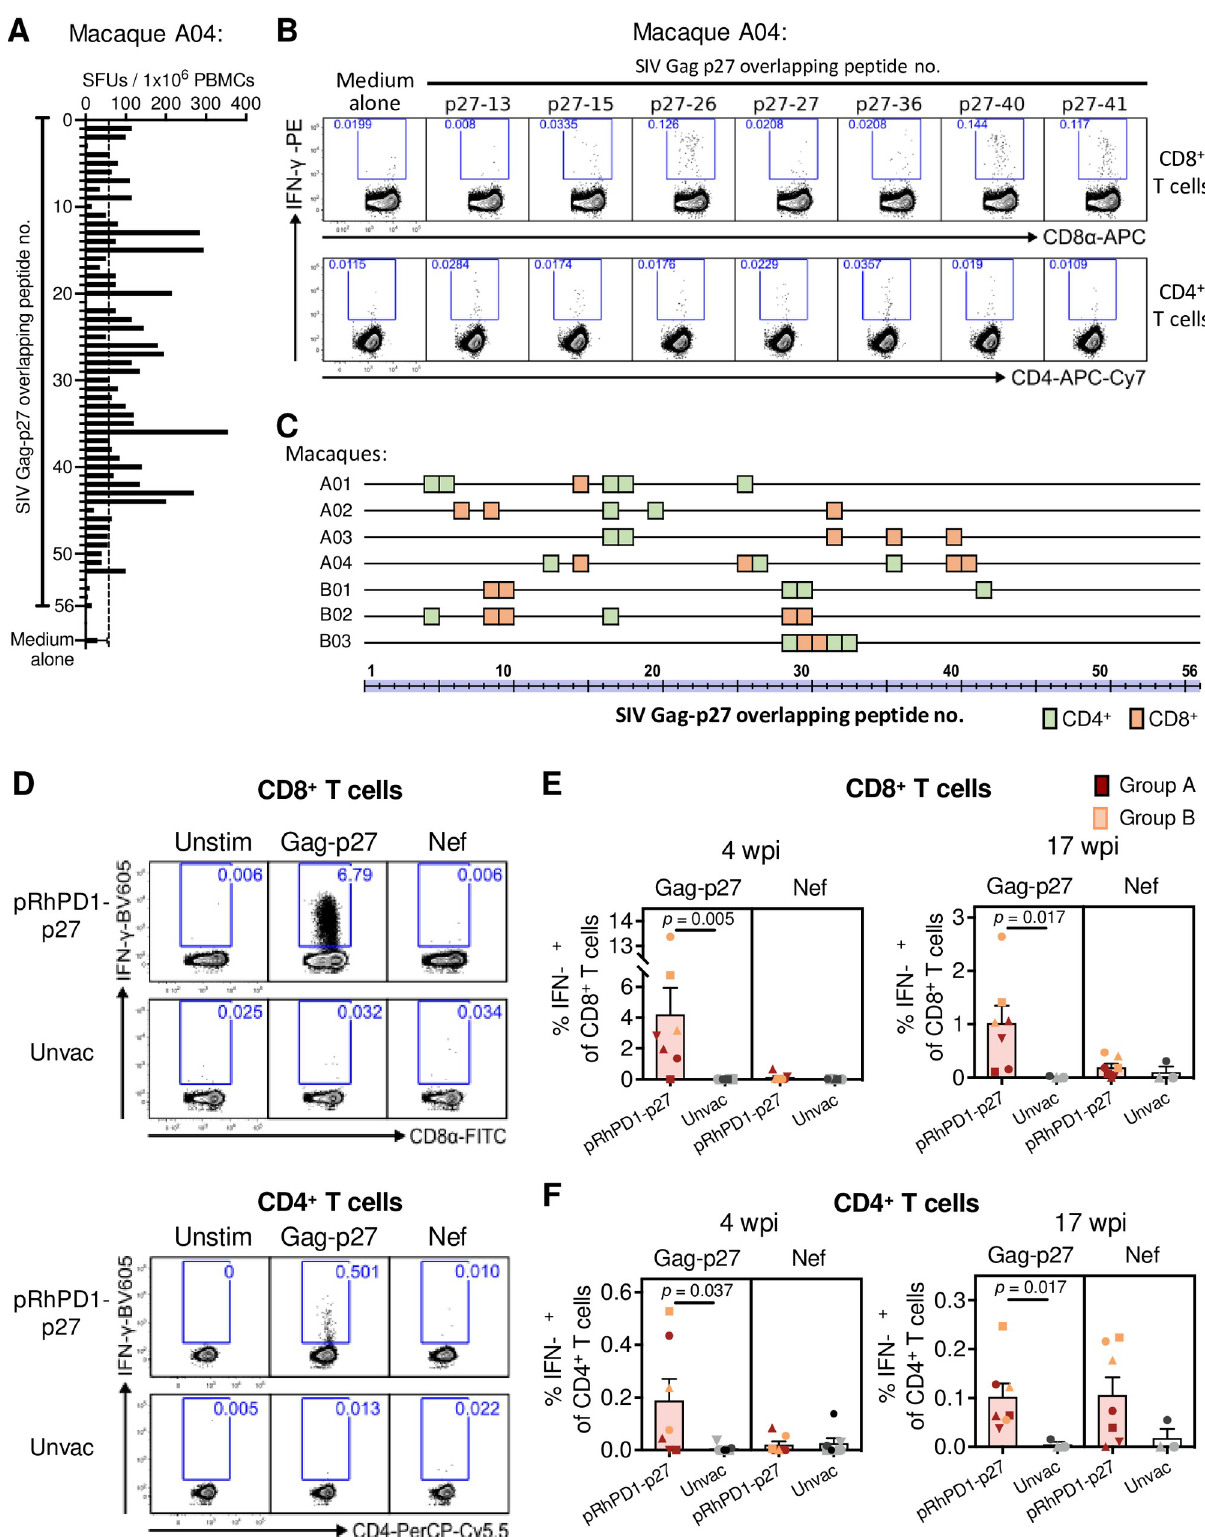
Fig 4. Specificities of the T cell responses induced by the pRhPD1-p27 vaccine. Representative results of T cell epitope mapping based on the IFN- γ ELISpot and ICS assays on macaque A04 from Group A. (A) PBMC isolated after third/fourth vaccination were stimulated with individual